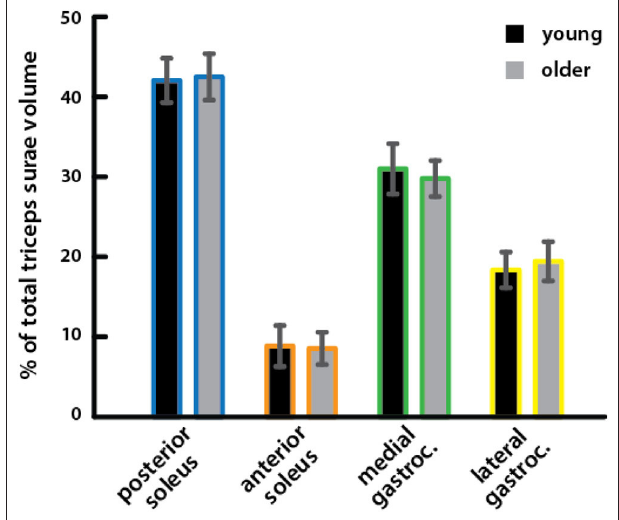
FIGURE 2 | Relative volumes of triceps surae muscles did not differ between young and older adults. Relative volumes of individual triceps surae muscles as a percentage of the total triceps surae volume are shown for young (black) and older (gray) adults. A Mann–Whitney rank sum test detected no significant differences between young and older adults for any muscle ( Table 2